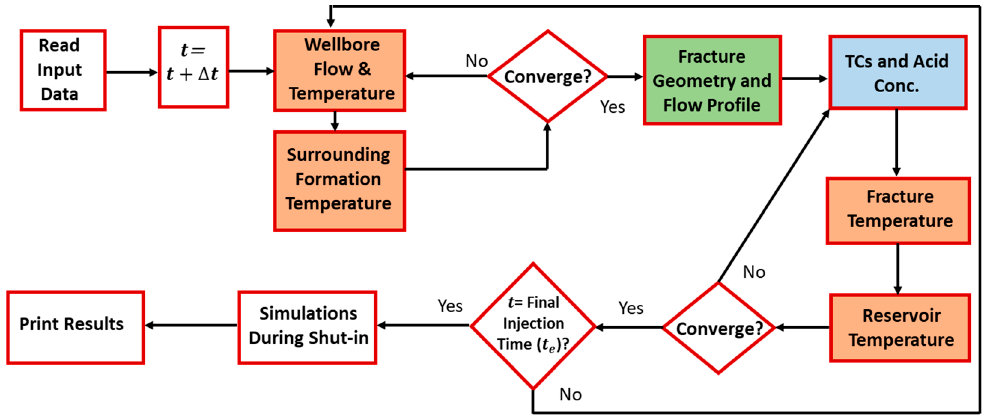
Figure 1. Model algorithm of the fluids’ reactive transport.